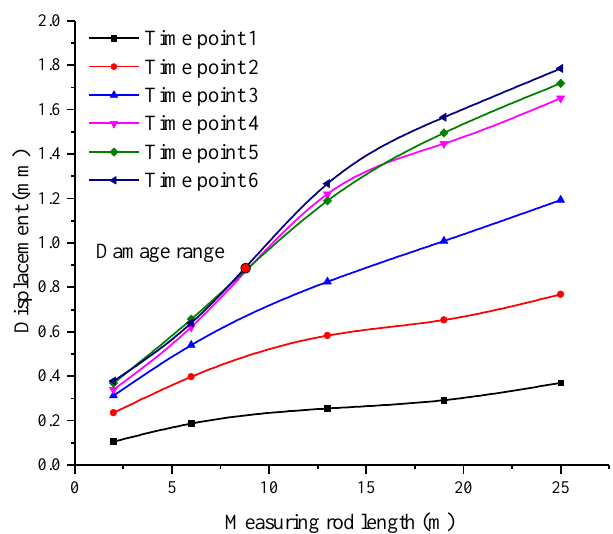
Figure 13. Internal displacement duration curve.